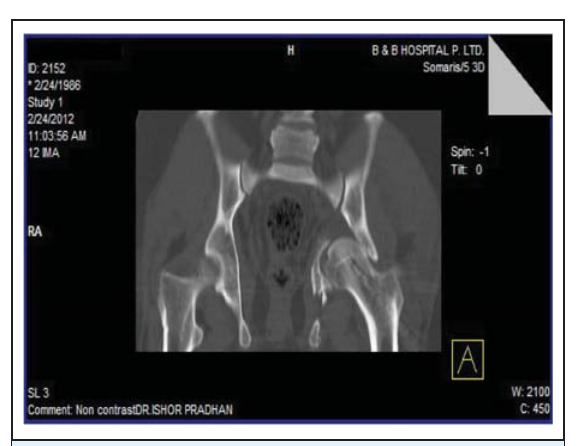
Figure 3. 26 Y/M. Multiplanar reformation image shows comminuted fracture of the left acetabulum with central dislocation.